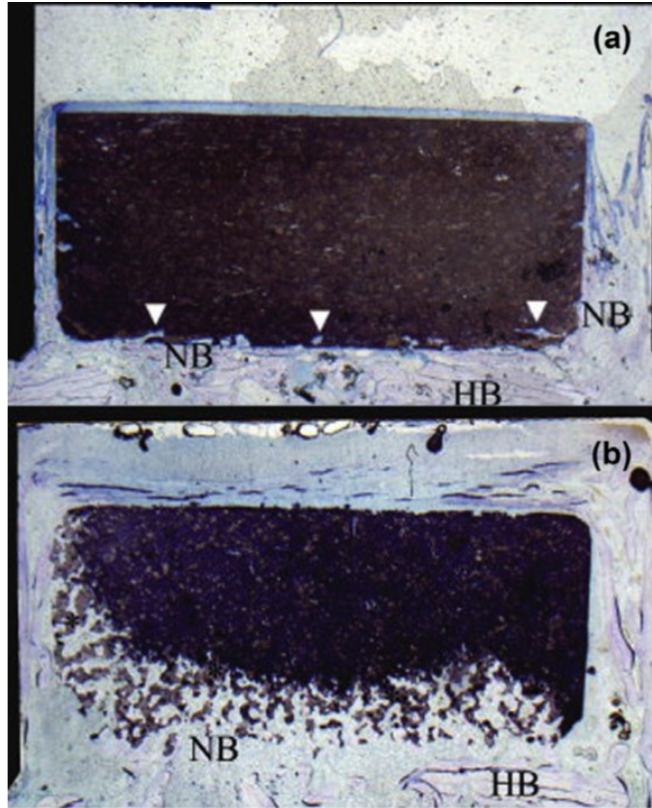
Figure 7. The image showing degradation behavior of ( a ) β -TCP and ( b ) α -TCP block in the calvaria region of rabbits after 8 weeks implantation. It was found that the α -TCP block showed considerably more degradation than the β -TCP [105]. NB = new bone; HB = host